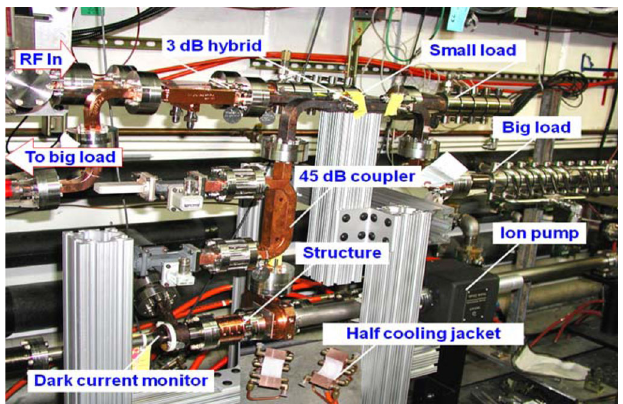
FIG. 4. The input forward, reflected, and dissipated power for the SW cavity test. The prepulse is the power leaked from SLED-II during compression, the main pulse is the discharged compressed pulse, and the after pulse is the remaining stored energy emitted from the delay lines after the klystron pulse.